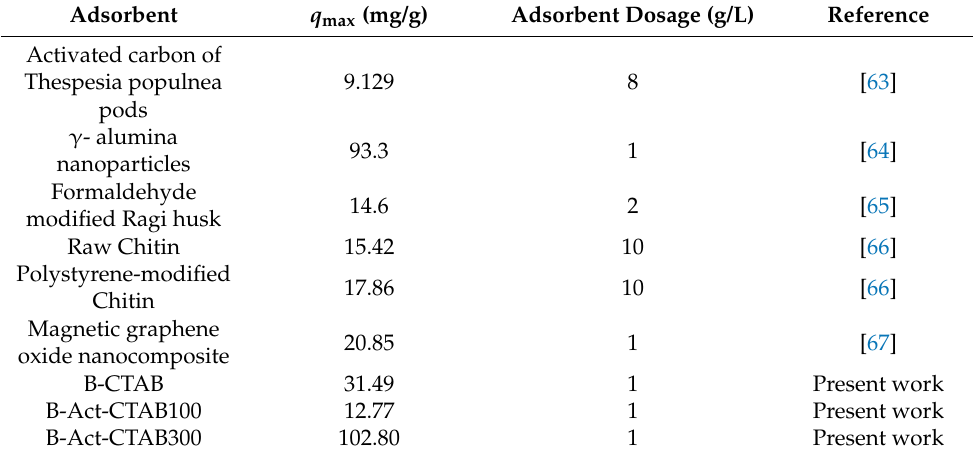
Table 6. Comparison of adsorption capacity of B-CTAB, B-Act-CTAB100 and B-Act-CTAB300 with other published